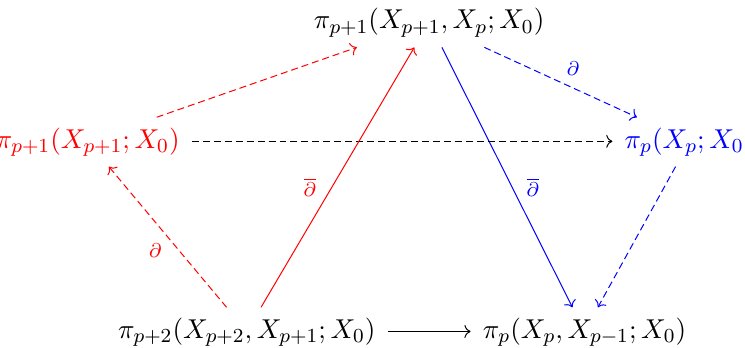
Figure 19 . The two colored maps factors through the dashed ones marked by the same colors. The composition depictured by the dashed black arrow is the trivial